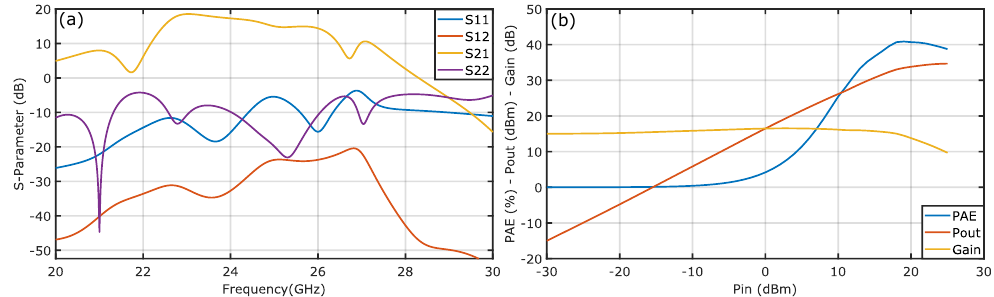
Figure 3. ( a ) S -parameters and ( b ) CW large-signal characteristic of the DIDPA when the nominal bias and input splitting are